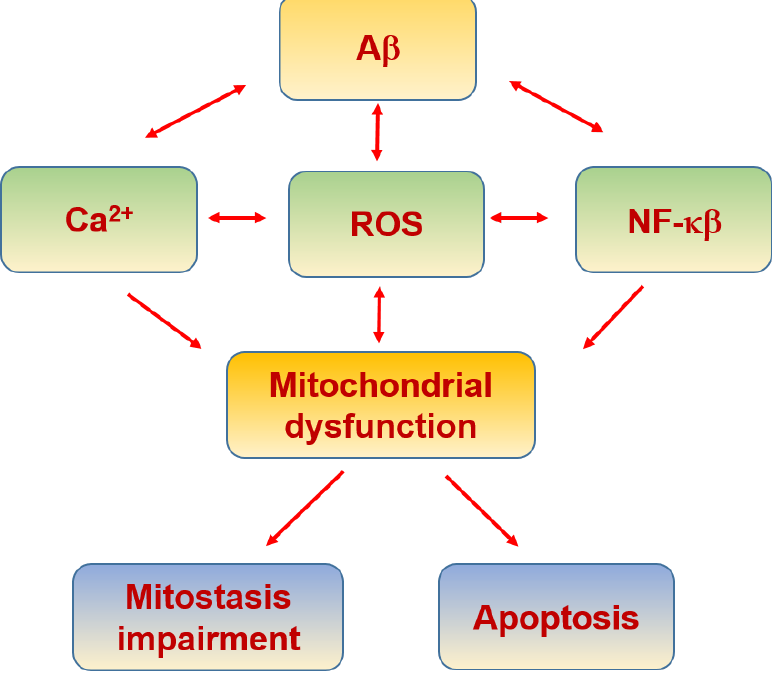
Figure 8. Alzheimer’s disease and mitochondria.